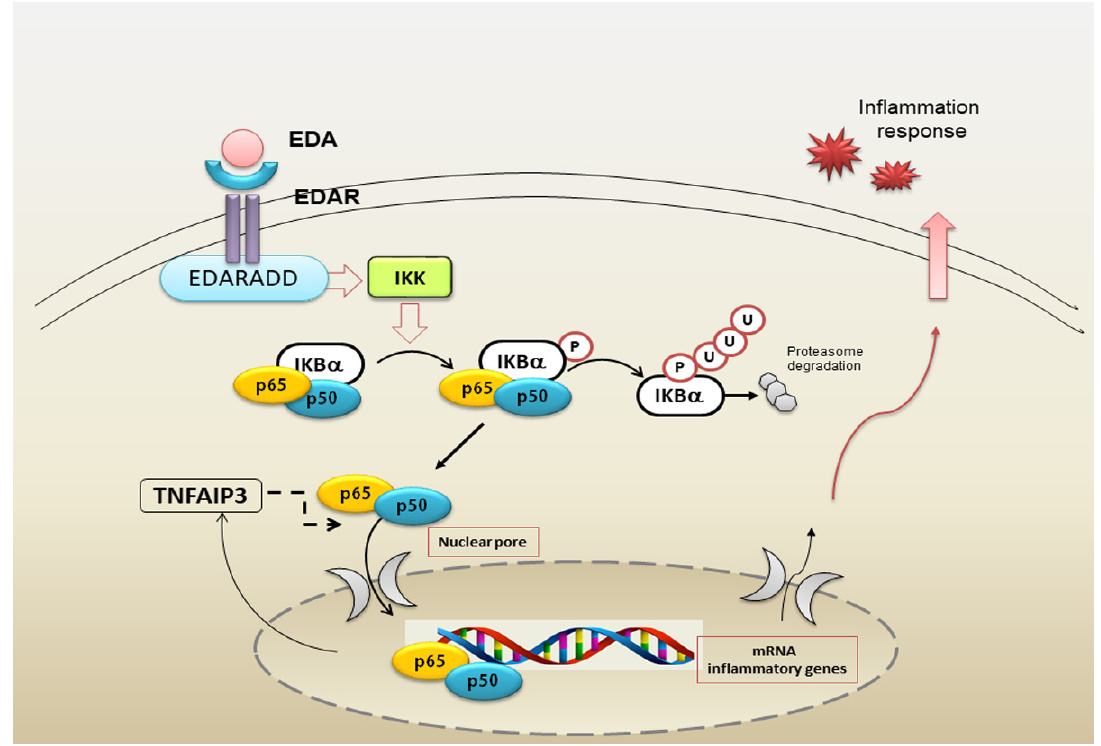
Figure 3. Schematic overview of the EDA / EDAR / canonical NF- κ B pathway. The EDA isoform of the TNF- α family member Ectodysplasin interacts with its receptor EDAR leading to the recruitment of EDARADD (death domain adaptor); in turn, this complex activates the IKK complex. The IKK complex phosphorylates I κ B α , that undergoes ubiquitylation and proteasomal degradation, inducing nuclear translocation of the NF- κ B heterodimer RelA / p50 that triggers the transcription of pro-inflammatory genes, including those that encode the negative regulators I κ B α and TNF- α -induced protein 3 (TNFAIP3). EDA: Ectodysplasin-A; EDAR: Ectodysplasin-A Receptor; EDARADD: Ectodysplasin-A receptor-associated associated death domain.